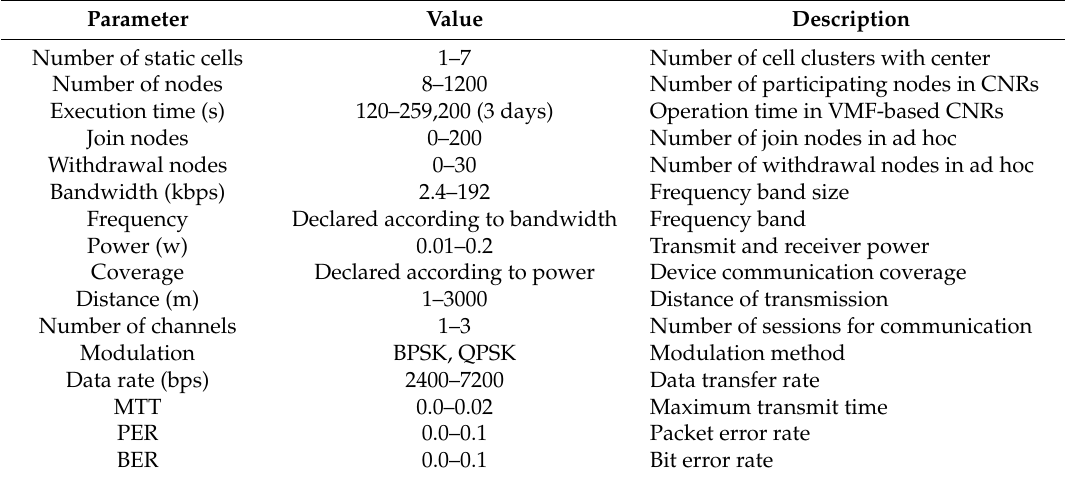
Table 6. Examples of communication parameters in physical layer-related VMF standards.